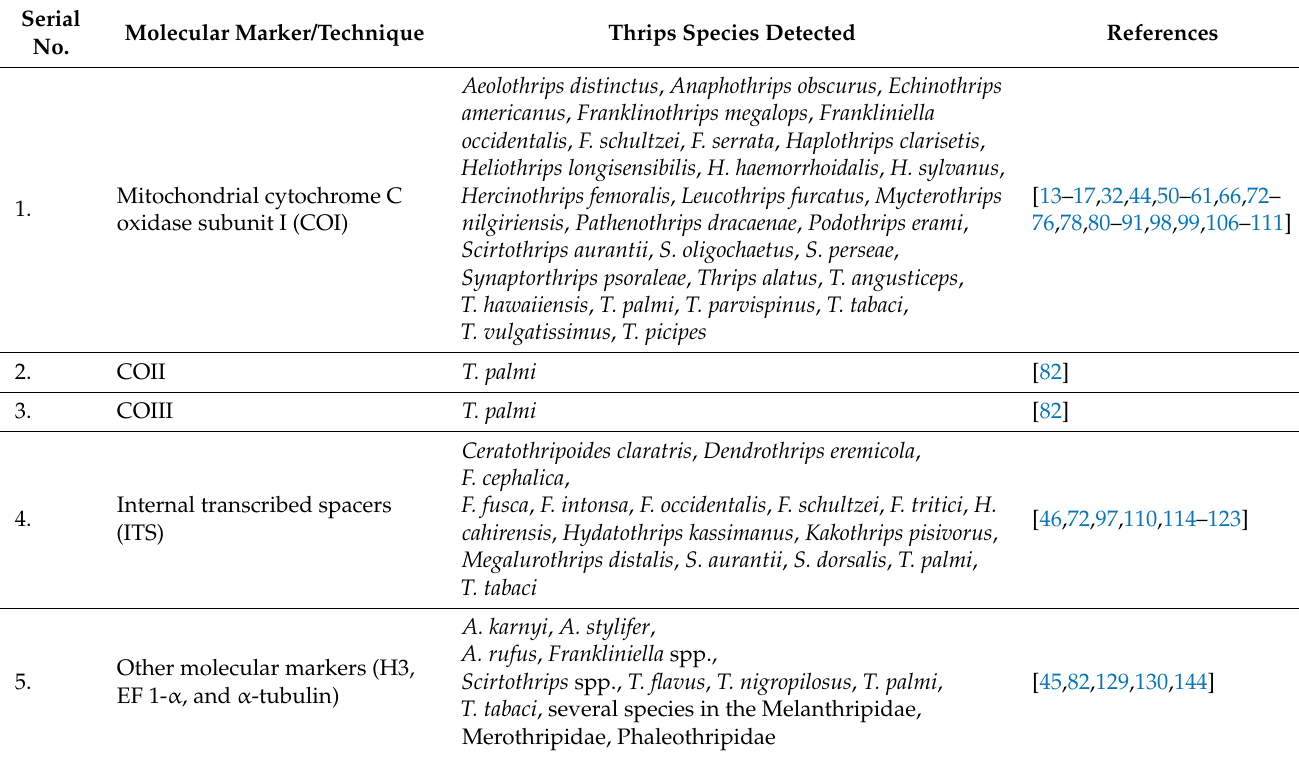
Table 1. List of molecular diagnostics reported for different thrips